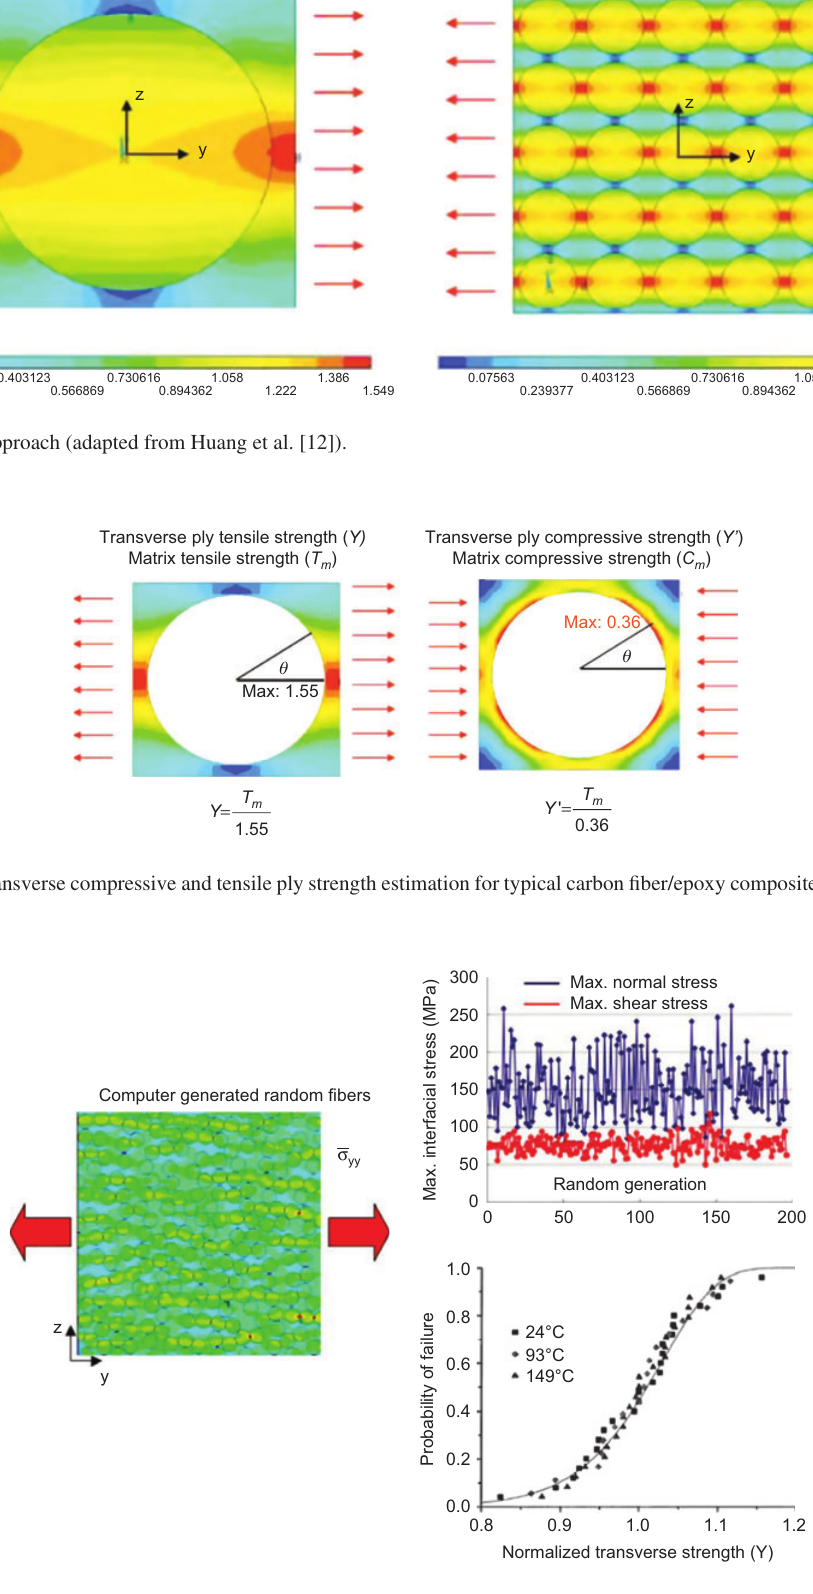
Figure 8 Computer generated random array for fi ber volume of 60 % submitted to transverse tensile load (adapted from Huang et al. [12]